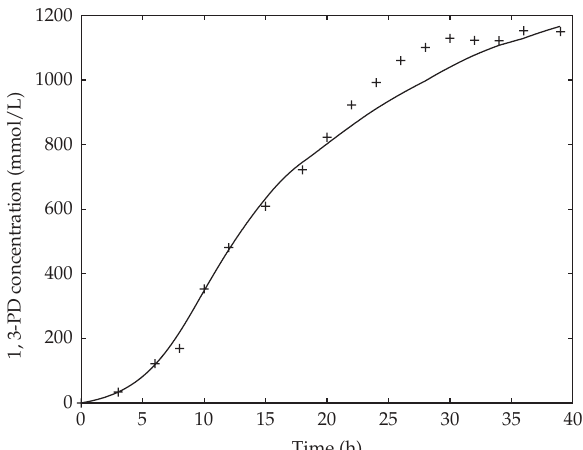
Figure 4: Comparison of 1,3-PD concentration between experimental data and computational